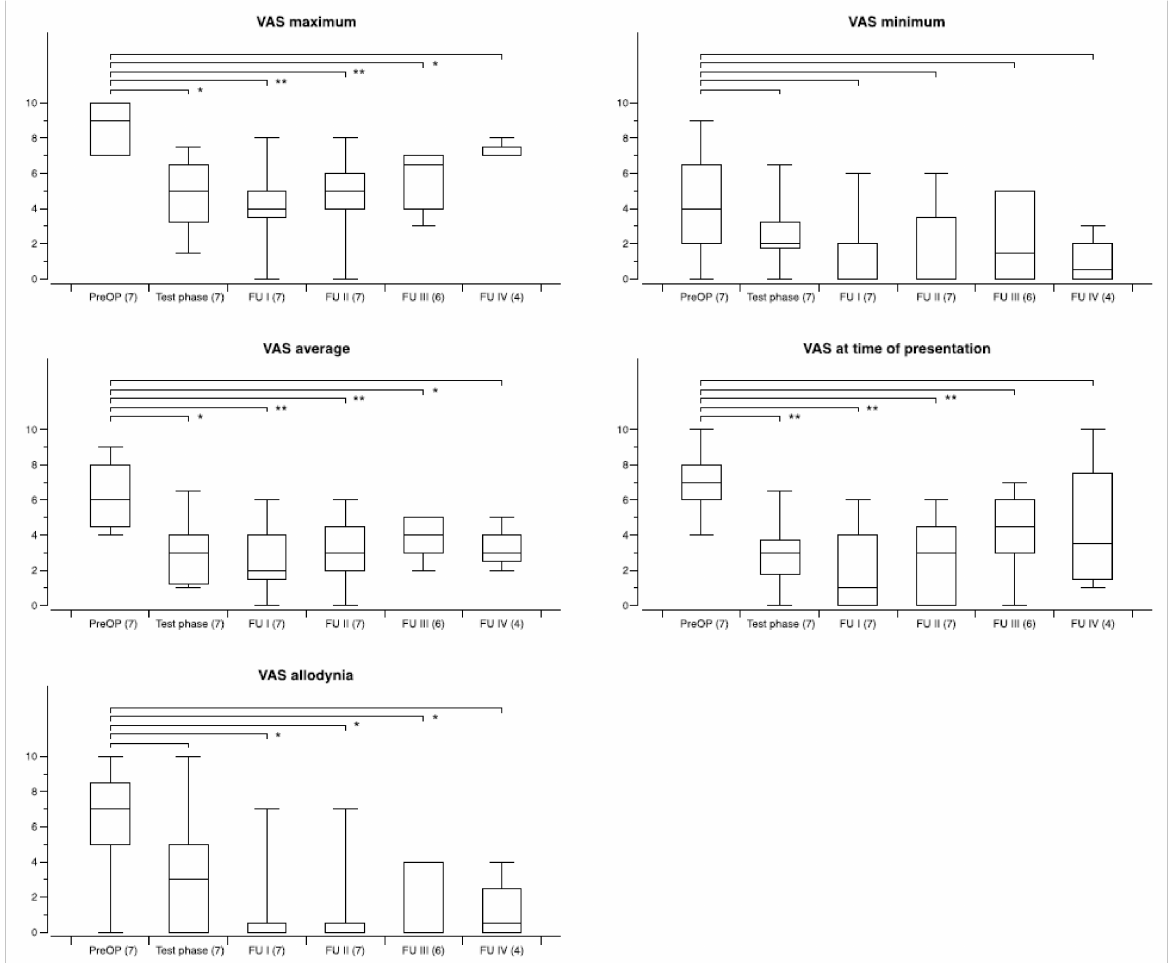
Figure 5. Development of specific VAS pain scores during thalamic stimulation in a group of seven patients with post- stroke/central pain (except thalamus). The number of patients available at the different time points is shown in brackets. Follow-up examinations were obtained at FU I: 3–12 months postoperatively, FU II: 12–23 months, FUP III: 24–47 months, and FU IV: 48-and longer. Box and whisker plots of test results over time. Boxes represent the first, second (mean), and third quartile of scores. Whiskers outline the maximum and minimum. The level of significance for the different follow-up periods as compared to preoperatively is indicated by * (* p < 0.05; ** p < 0.01; *** p < 0.001).